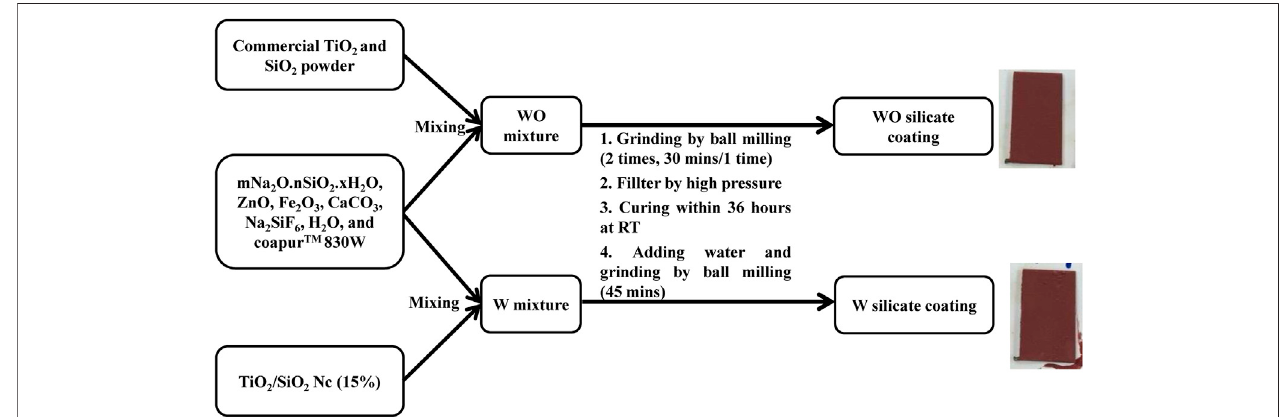
SCHEME 2 | The preparation procedure of WO and W silicate coatings.